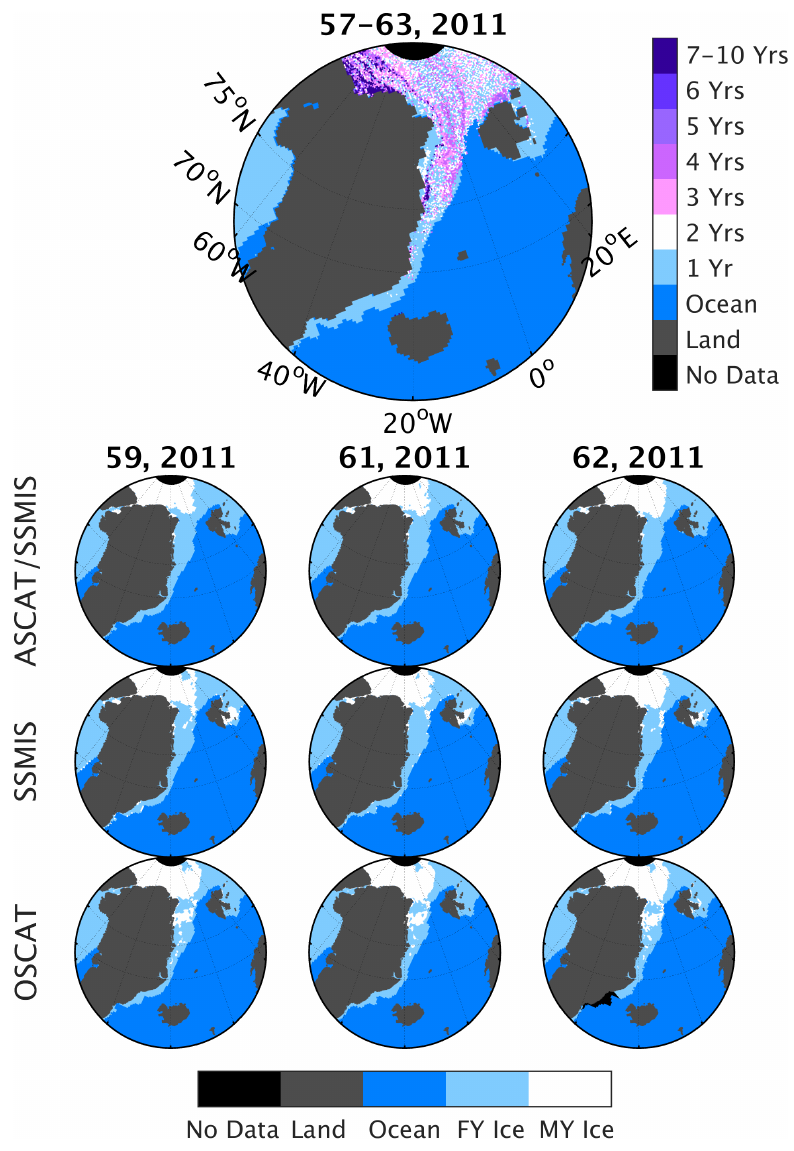
Figure 5. Collection of ice classifications from the EASE-Grid Sea Ice Age product (top), ASCAT/SSMIS (second row), SSMIS (third row), and OSCAT (fourth row). The EASE-Grid product is provided